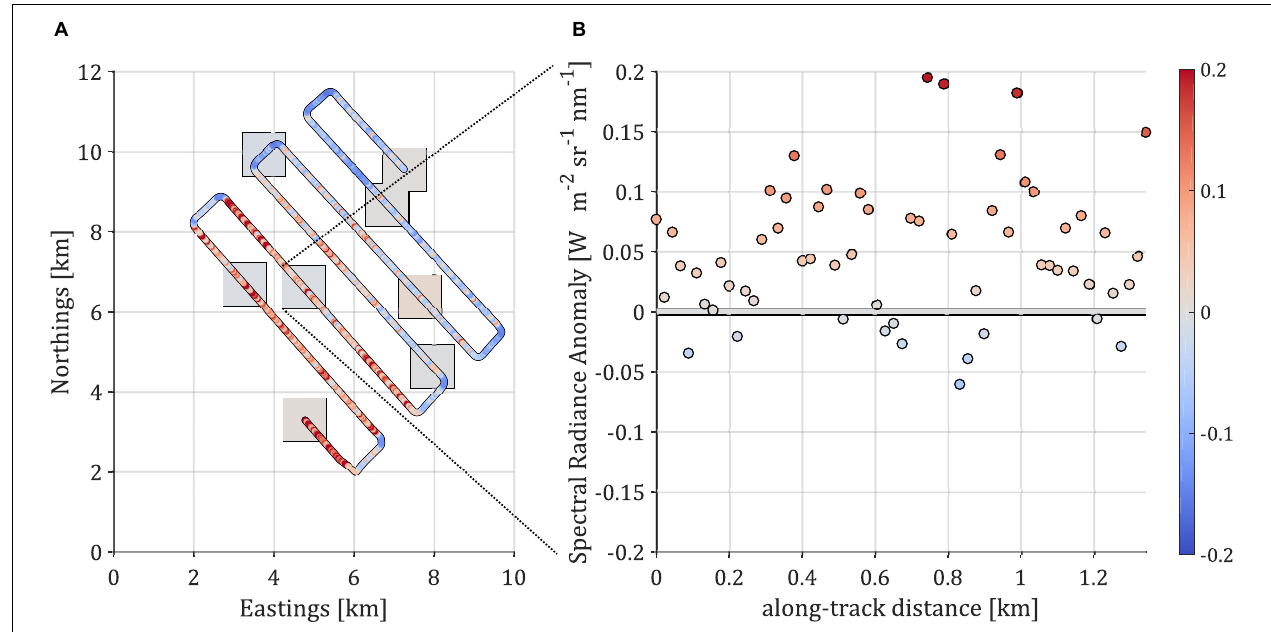
FIGURE 9 | Spectral radiance anomaly in W m − 2 sr − 1 nm − 1 at 488 nm wavelength, VNIR and MODIS, represented relative to the mean value of the latter over the entire UAV Flight001 area of operation. (A) UAV track overlaid on sample MODIS acquisition points (gray squares). Marker sizes are approximately equal to the size of each data point: 1 km by 1 km for MODIS and 175 m in the cross-track for the VNIR imager. (B) Snippet from track (as indicated by dotted lines), highlighting variability of spectral radiance within a single MODIS pixel (standard deviation: 0.0651 W m − 2 sr − 1 nm − 1 ). Colorbar represents the spectral radiance anomaly shown as the vertical axis in (B)